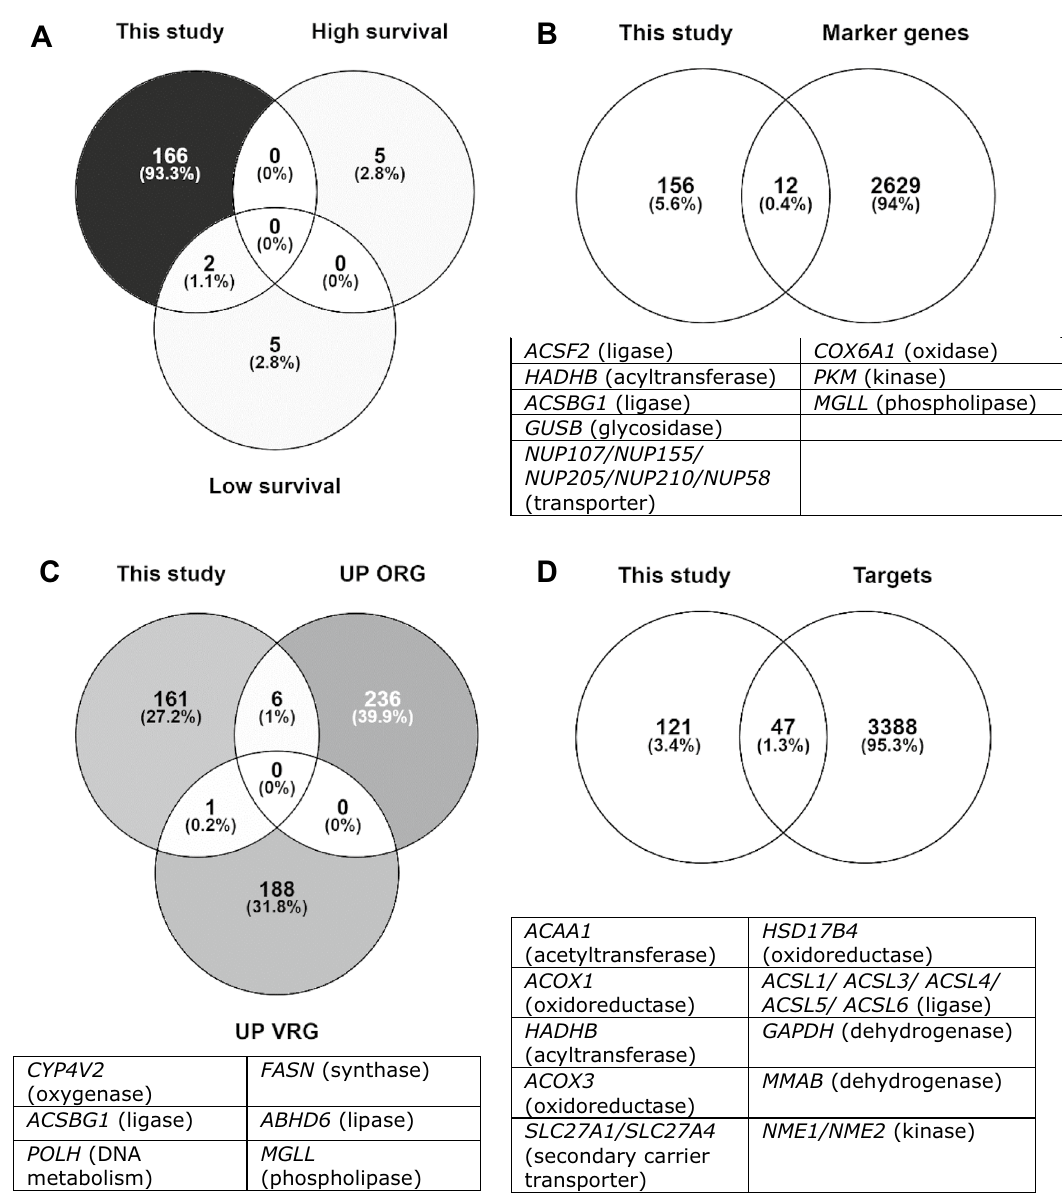
Figure 4. Comparison of genes of interest identified in this study against published works: ( A ) Larsson et al. 56 , which highlighted essential genes for models for high and low survival, ( B ) Richards et al. 9 , where the list of marker genes comprises the top 50 genes for each one of the 86 intra-GSC clusters, ( C ) Wang et al. 54 , where upregulated genes for outer RG-like and ventricular RG-like (UP ORG and UP VRG, respectively) were considered, and ( D ) Liu et al. 67 , where “targets” comprise both genes and miRNAs. Diagrams were made using Venny 68 . Panels B, C and D include tables informing about the protein type (most of them are